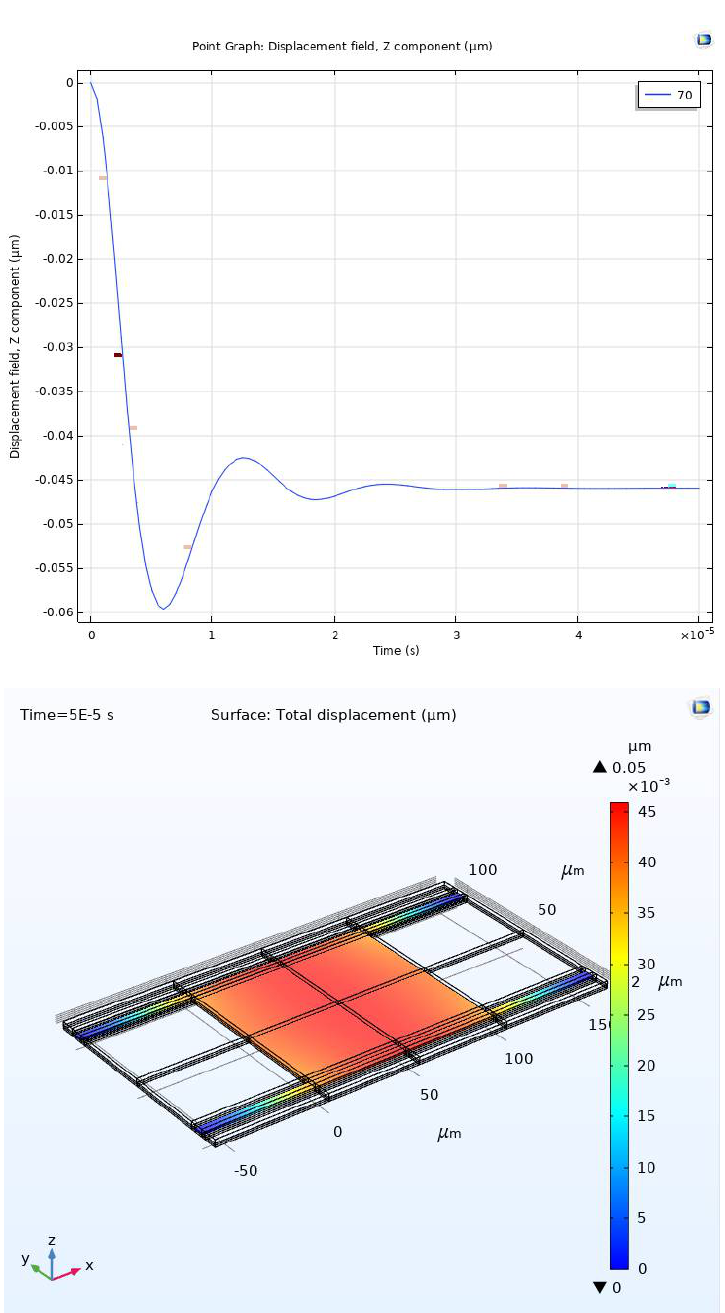
Figure 15. Stabilization at the first third of the full gap: top graph (1-D), bottom graph (3-D).